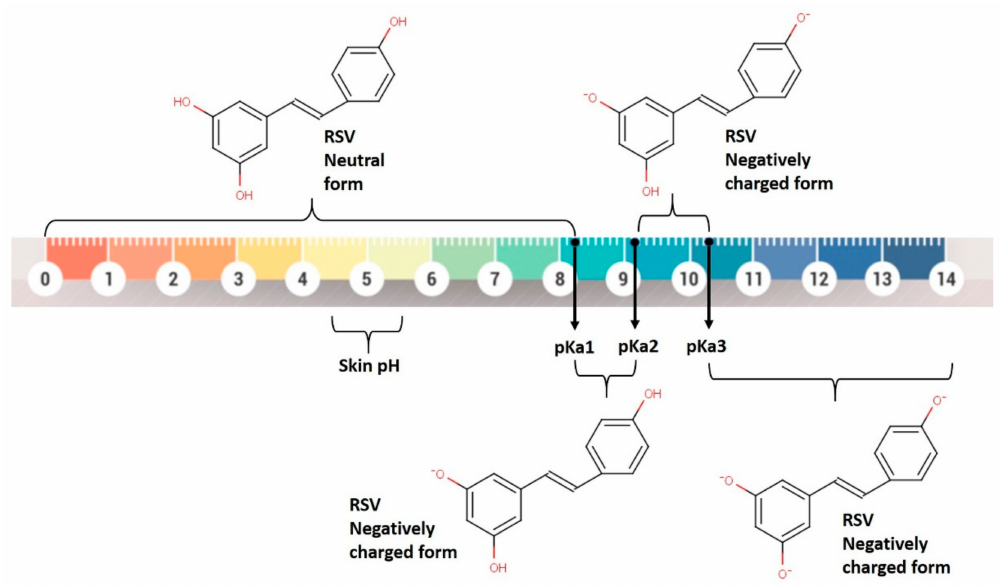
Figure 1. RSV microspecies distribution (neutral and negative) according to pH. The pKa values of RSV are also represented. The chemical structure of RSV was drawn using Marvin Sketch software from Chemaxon ®